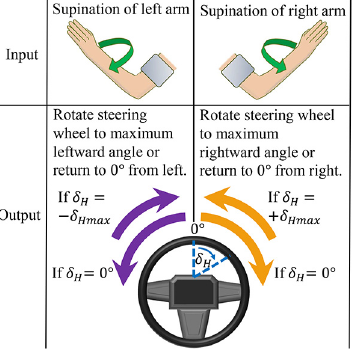
Figure 3 Relation between sEMG input and rotational output of steering